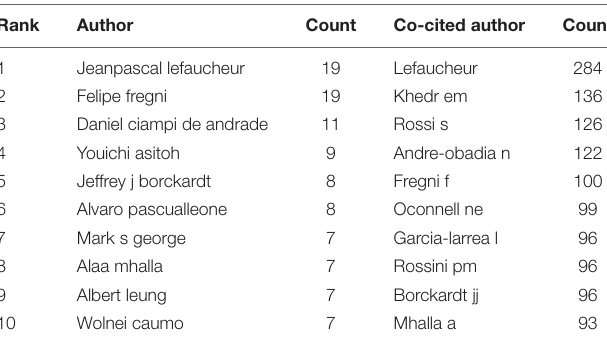
TABLE 4 | The top 10 authors and co-cited authors in TMS research in